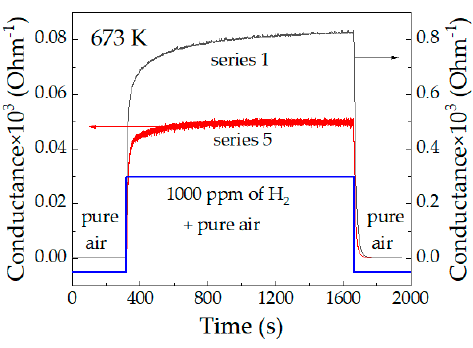
Figure 5. The time dependencies of the sensor’s conductance at exposure to 1000